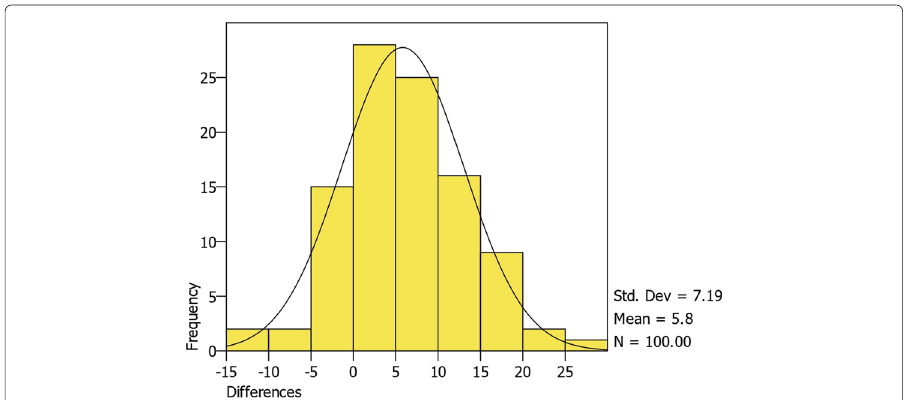
Fig. 16 Normality test of the dependent variable, the mean differences between pre-test and post-test PSVT